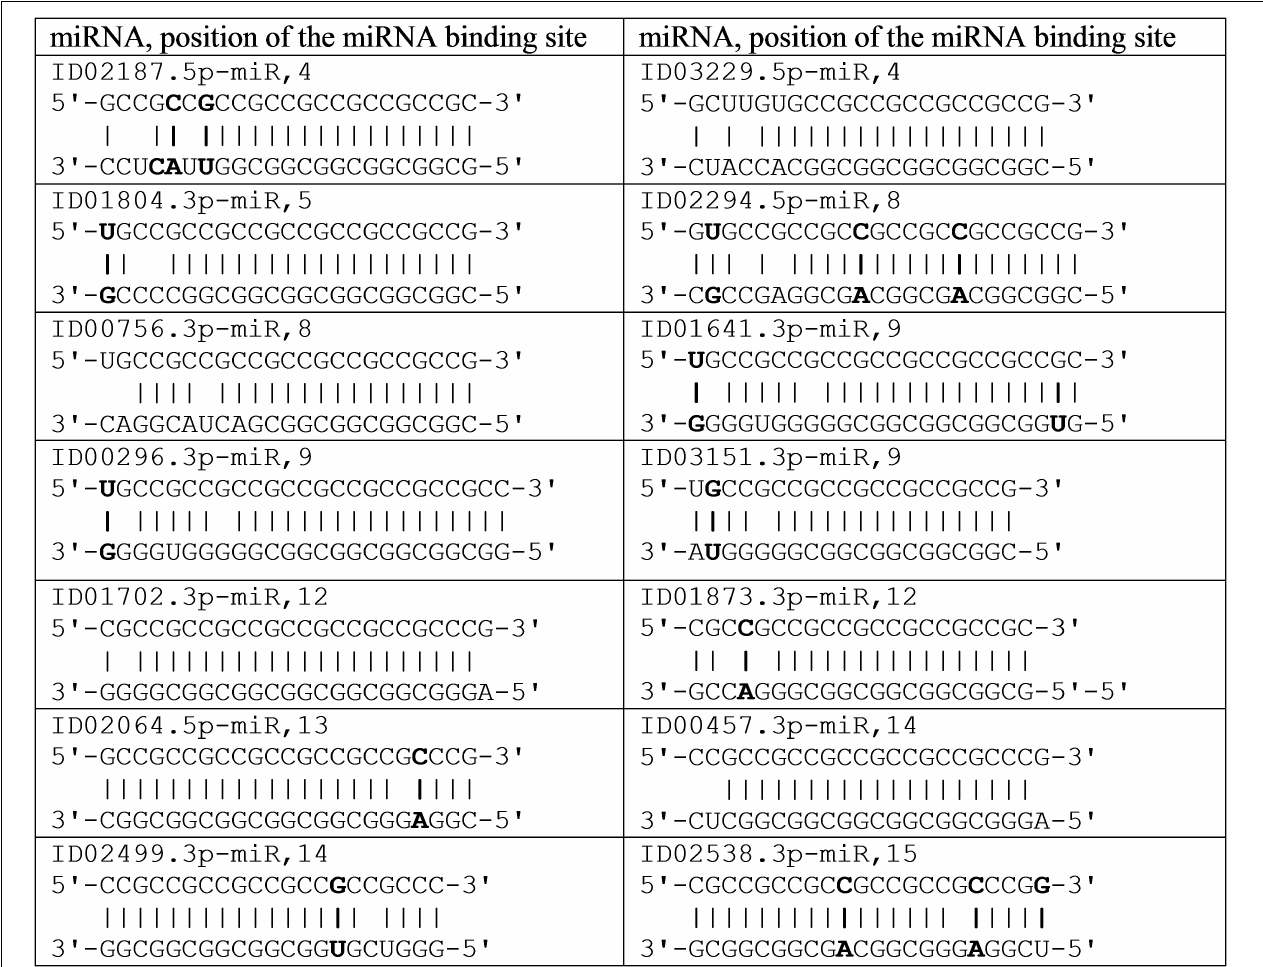
FIGURE 3 | Schemes of miRNA interaction in cluster 5 (cid:48) UTR mRNA of the candidate GSK3B gene for Parkinson’s disease.